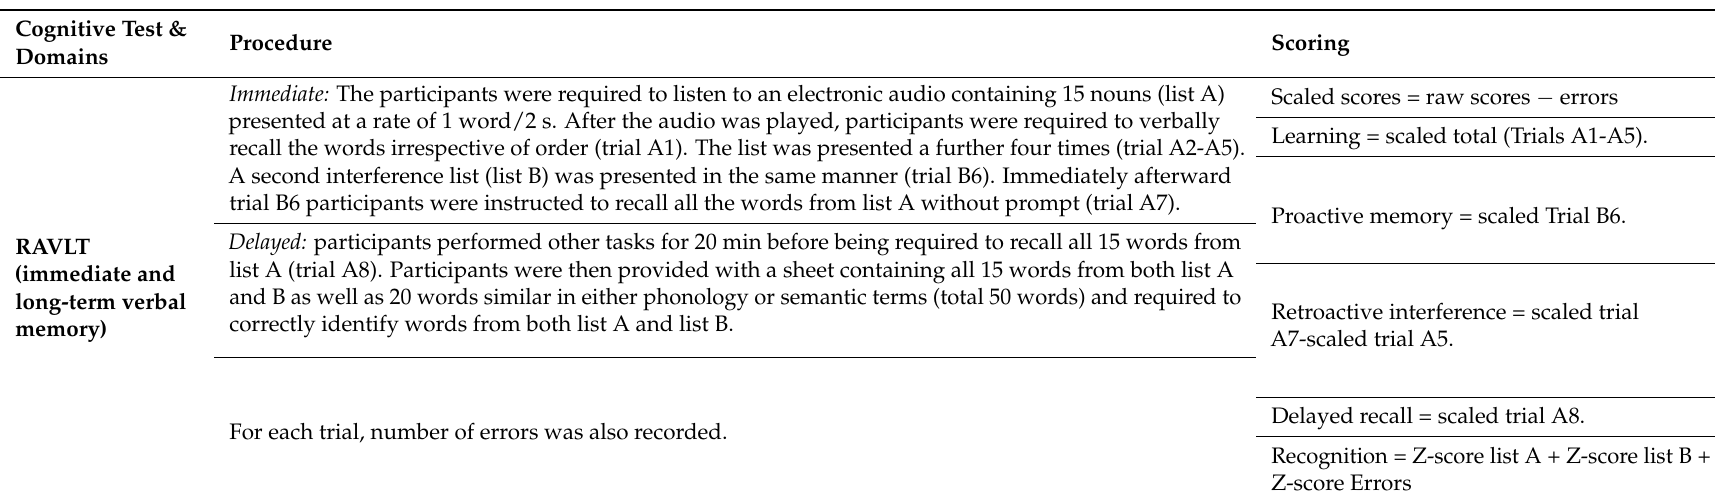
Table 2. Components of the Neuropsychological test